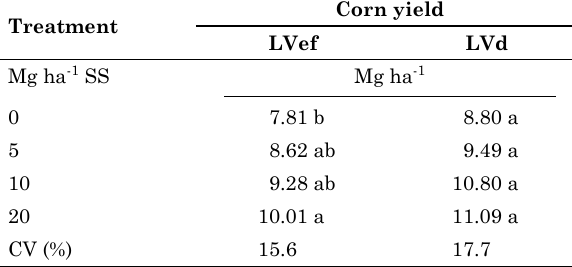
table 7. Corn yield cropped in dystrophic (lVd) and eutroferric (lVef) Latossolo Vermelho treated for 16 years with sewage sludge at different rates